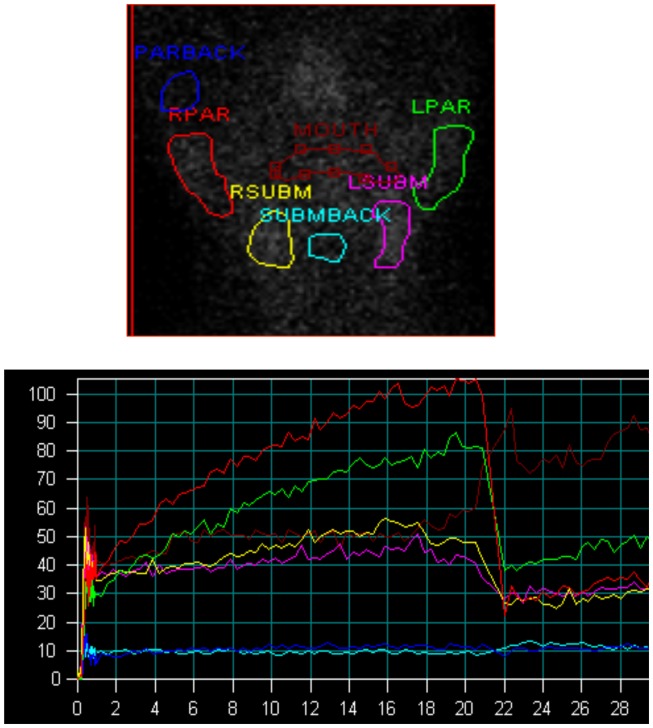
Salivary scintigraphy. Upper figure shows regions of interest, lower figure shows time activity curves (y axis = counts per second, x axis = minutes, lemon juice was administered at the 20 min time point). Red = right parotid, green = left parotid, yellow = right submandibular gland, pink = left submandibular gland, blue = parotid background, turquoise = submandibular background, brown = mouth.